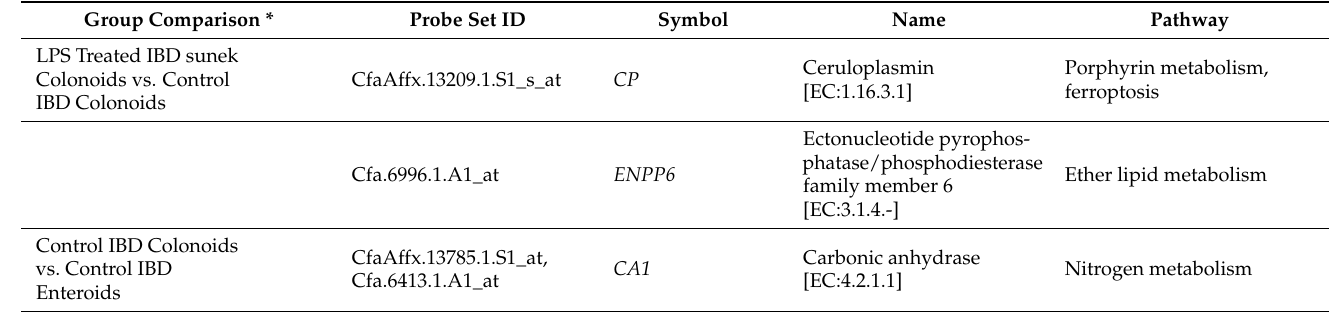
Table 15. The KEGG enrichment analysis results by Blast2GO [48]. The details of each KEGG pathway [45–47] are available at https://www.kegg.jp/kegg/kegg1.html. * Top upregulated and downregulated genes were studied by Blast2GO